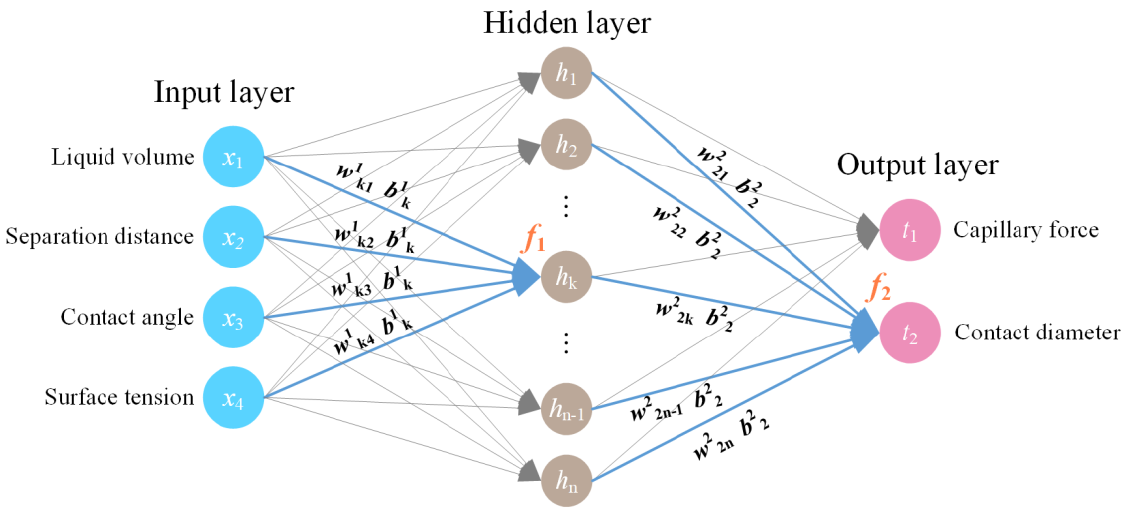
Figure 1. ANN neuronal structure.